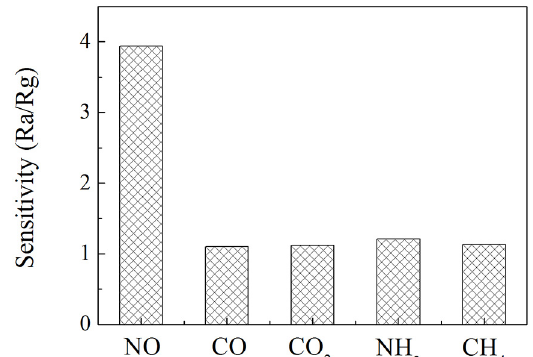
MoO sensor to other interference 2 6